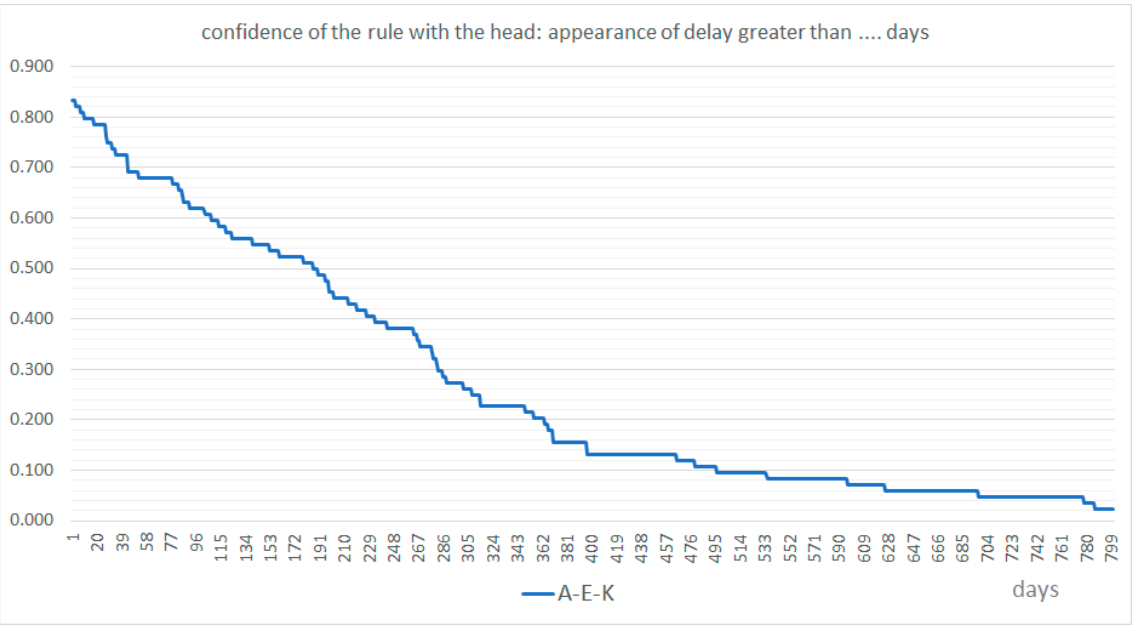
Figure 9. The confidence of the rule if A-E-K, then D for different number days as the threshold of the head